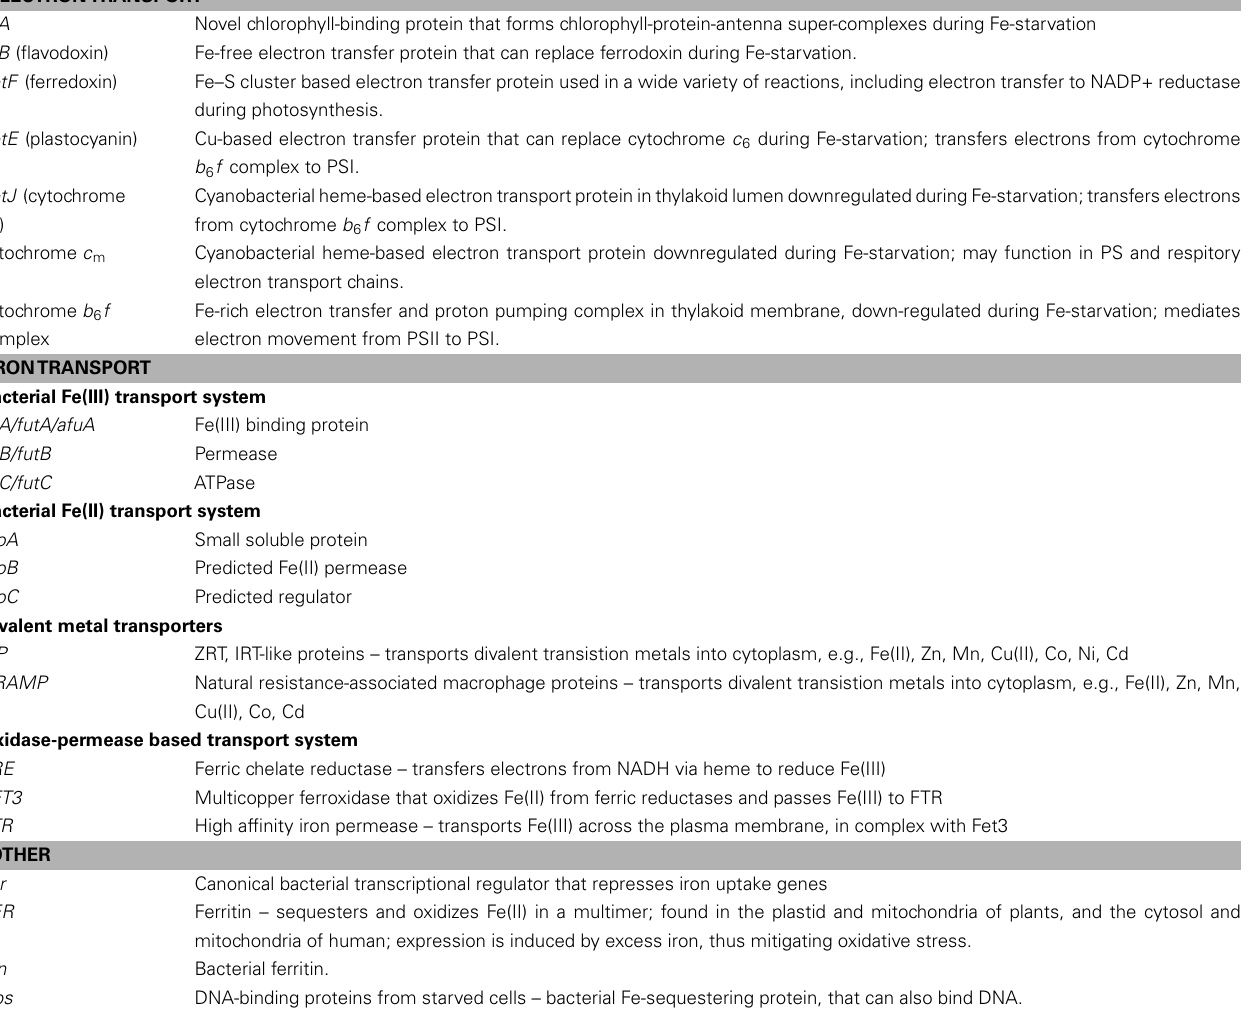
Table 1 | Iron-related genes and proteins mentioned in the review (see text for reference).